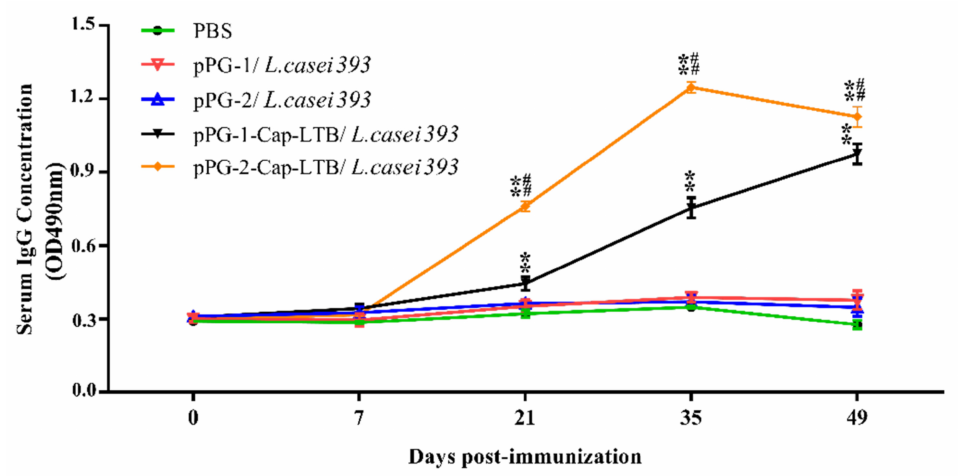
Figure 3. Specific IgG antibody levels in mice post-immunization. Measurement of specific anti-PCV2 IgG by an ELISA using PCV2 as the coating antigen. Bars represent the mean SE in each group (* p < 0.05, ** p < 0.01 compared to the control groups: pPG-1/ L. casei 393 and # p < 0.05, ## p < 0.01 compared to group: pPG-2/ L. casei 393